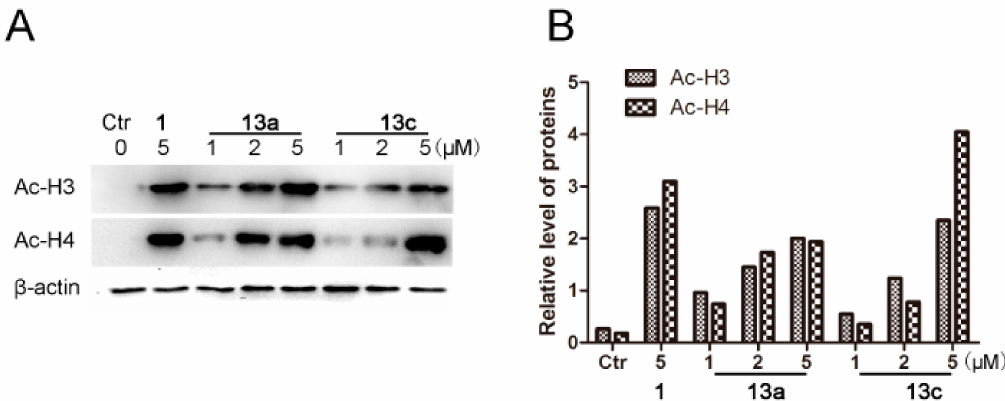
Figure 4. Western blot analysis of the e ff ects of compounds 13a and 13c on acetylated histone levels in MDA-MB-231 cells. ( A ) MDA-MB-231 cells were treated with 13a , 13c and SAHA for 48 h at the indicated concentrations, and the levels of protein expression were detected using anti-acetyl-histone H3, H4 and anti- β -actin antibodies, respectively. β -Actin was used as the loading control. ( B ) Quantitative analysis. The relative levels of Ac-H3 and Ac-H4 used to control β -actin were determined by densimetric scanning.